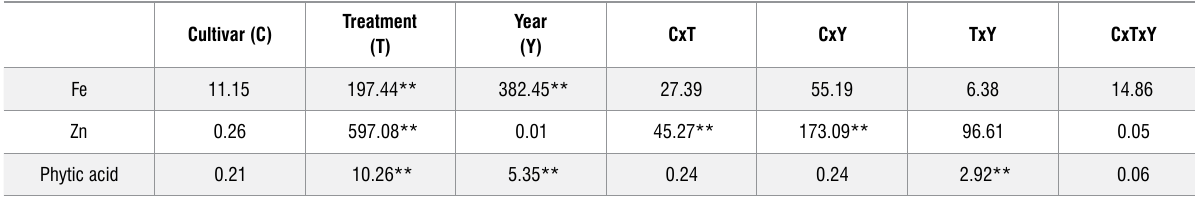
Analysis of variance for Fe, Zn and phytic acid concentrations in a trial of two wheat cultivars with four treatments over two years Cultivar (C)